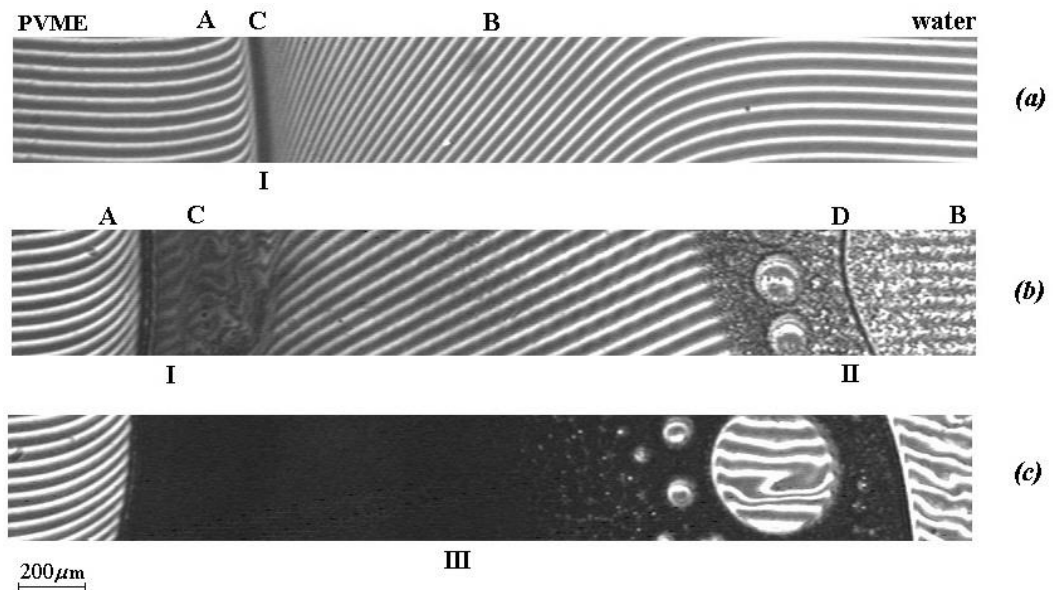
Figure 1. Interferograms of the interdiffusion zones of the poly(vinyl methyl ether) (PVME)-water system, obtained in the mode of a stepwise rise of temperature at ( a ) 22 ◦ C, ( b ) 22 ◦ C → 32 ◦ C, ( c ) 32 ◦ C → 35 ◦ C (see text for details). The interaction time of the components with a stepwise rise of temperature corresponds to ( a ) 85 min, ( b ) 370 min, and ( c ) 397 min from the beginning of the